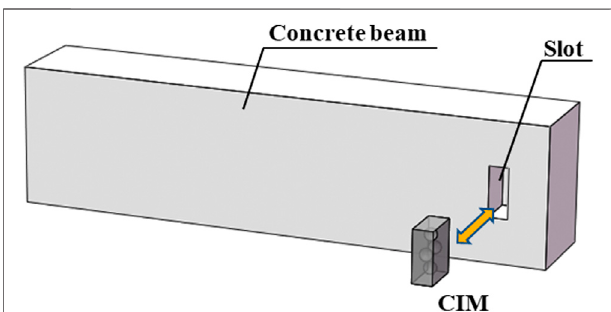
FIGURE 4 | Implanting the CIM into a concrete structure.